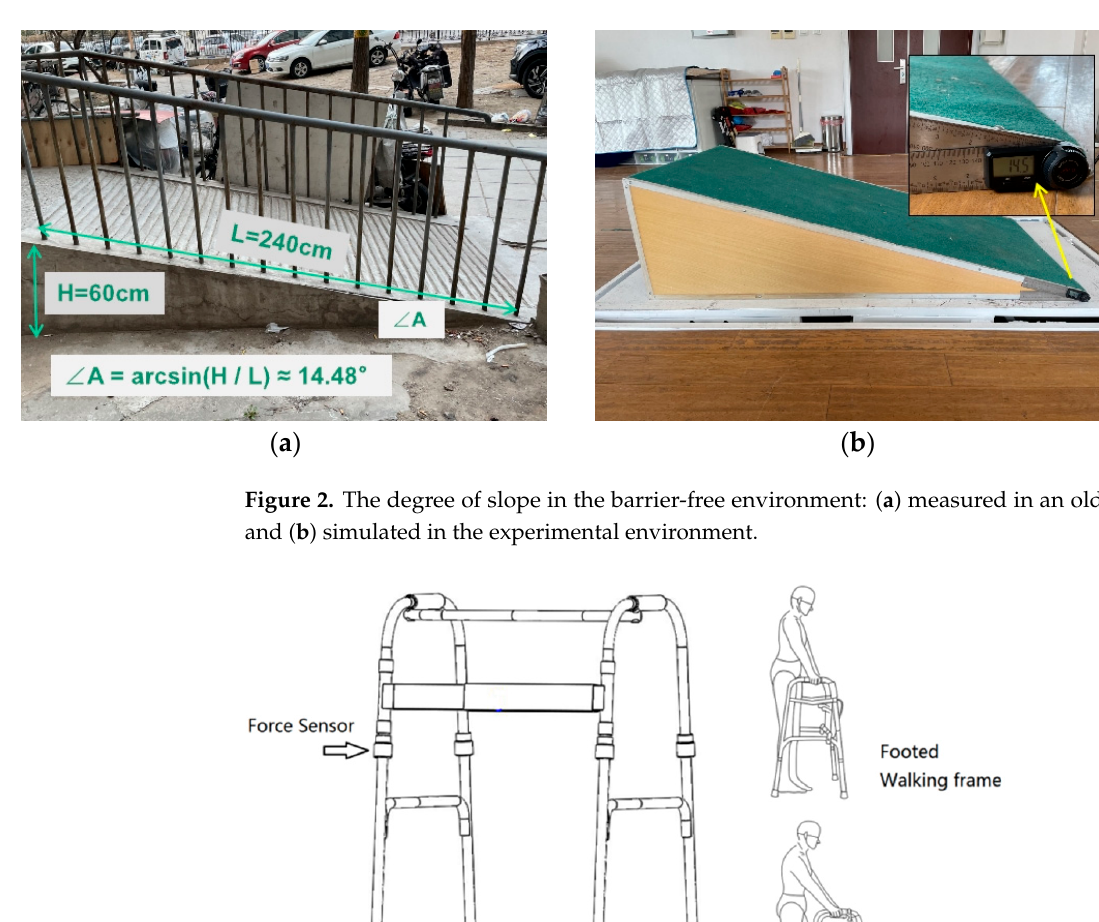
Figure 2. The degree of slope in the barrier-free environment: ( a ) measured in an old community, and ( b ) simulated in the experimental environment.